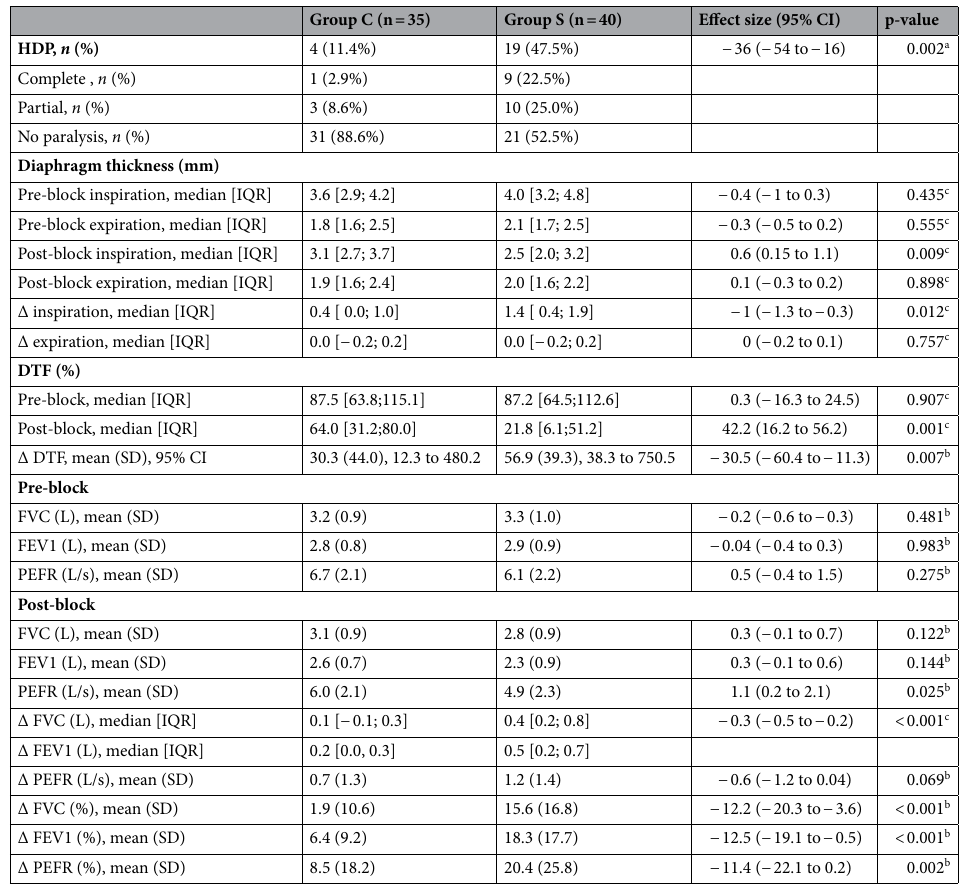
Table 2. Sonographic measurements of diaphragm and results of spirometry stratified by group. Effect size (risk difference for categorical variable, mean or median differences for continuous variables) are differences (Group C − Group S). The p-value < 0.016 was considered statistically significant using Bonferroni correction except the primary outcome. DTF diaphragm thickning fraction, HDP hemidiaphragmatic paralysis (DTF < 20%), FVC forced vital capacity, FEV1 forced expiratory volume in 1 s, PEFR peak expiratory flow rate, Δ delta (pre–post value), CI confidence interval. a Fisher’s exact test. b Independent t-test. c Mann–Whitney U